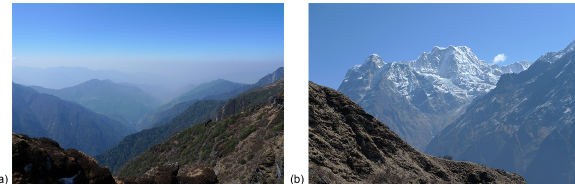
Figure 1. Photographs taken from the same location in the Inkhu Khola valley, Solu-Khumbu, Nepal at ∼ 4300m. (a) looking south. Note the presence of the Atmospheric Brown Cloud (a combination of BC, other pollutants and dust). Picture (b) looking northwards towards the crest of the Himalaya (here seeing the south side of Mera